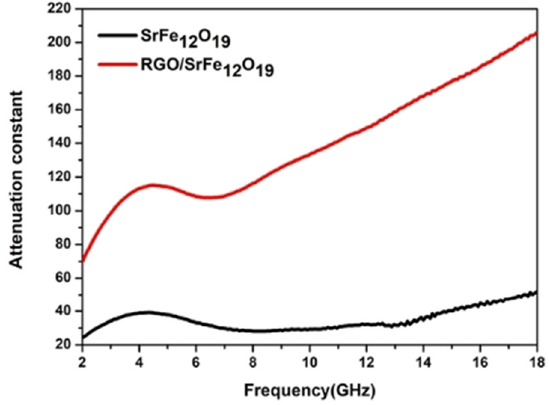
Figure 4: Attenuation constants of nanocomposites with changing frequency [ 45 ]